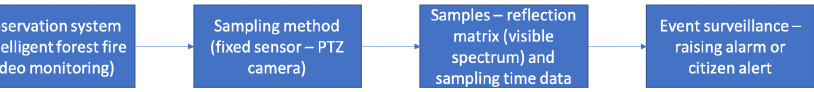
Figure 5. Concepts of the conceptual framework embodied in the Intelligent Forest Fire Monitoring and Surveillance system.